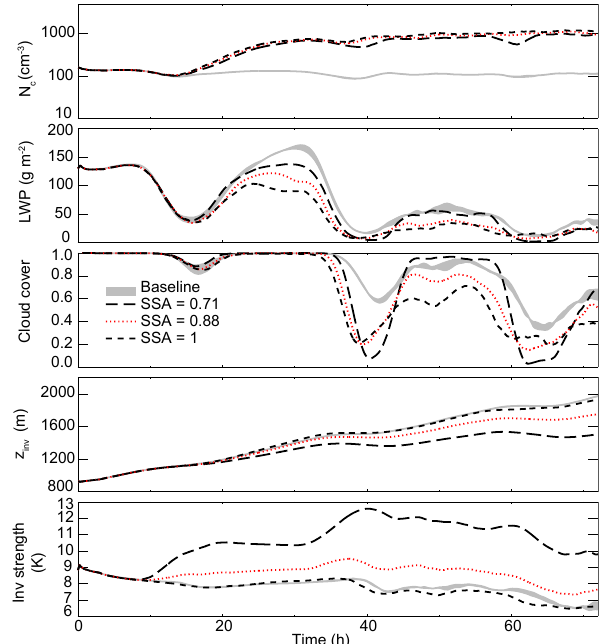
Figure A1. As in Fig. 2. Range of the three-member lightly driz- zling baseline ensemble ( N a , sulfate = 150mg − 1 ) in gray. Varying single scattering albedo (SSA) of absorbing aerosol as given in the legend.